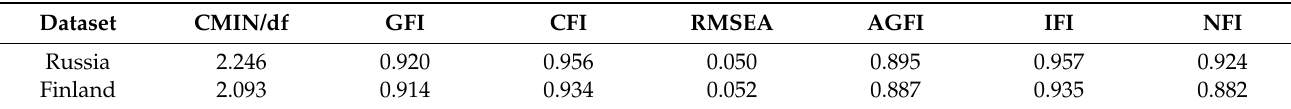
Table 4. The model fit results for Russian and Finnish